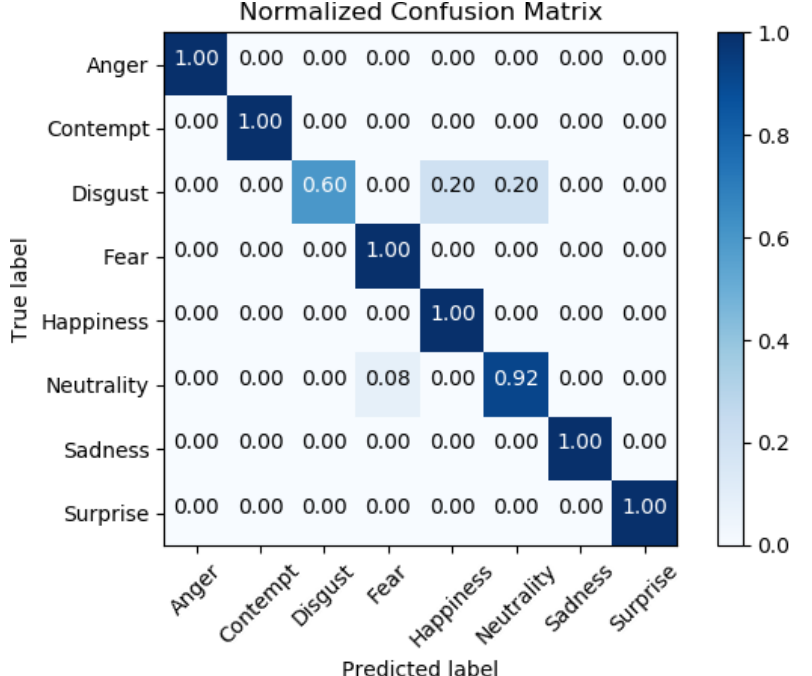
Figure 3. Normalized confusion matrix of the network in [21], trained with the CK+ database using the data augmentation and the z-score normalization. Figure from